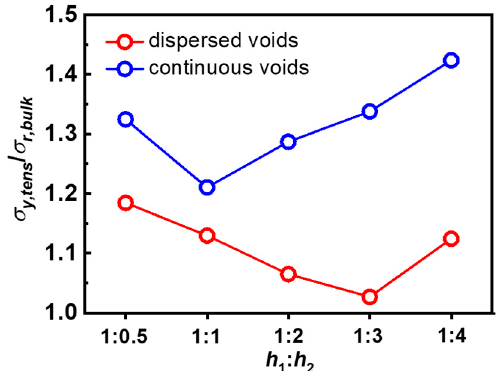
Figure 8. The normalized stress concentration ratio (the ratio between tensile yielding stress and critical bulk stress, σ y,tens / σ r,bulk ) as functions of spacing ratios h 1 : h 2 .